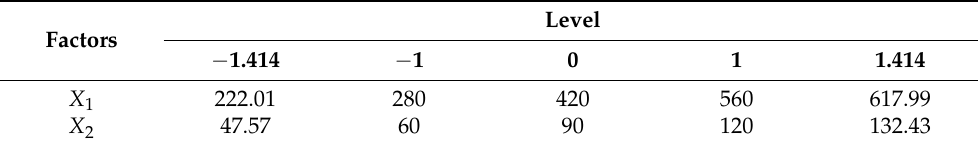
Table 2. Coded and actual levels of independent variables used in the central composite design for microwave-assisted